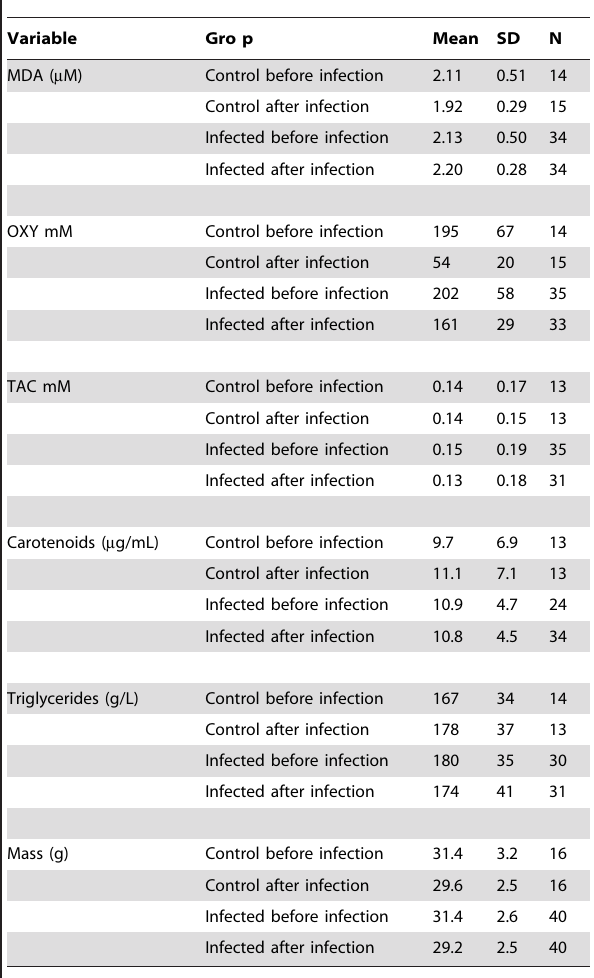
Table 1. Biochemical indices and body mass of greenfinches at first and second blood sampling (before and after experimental infection).